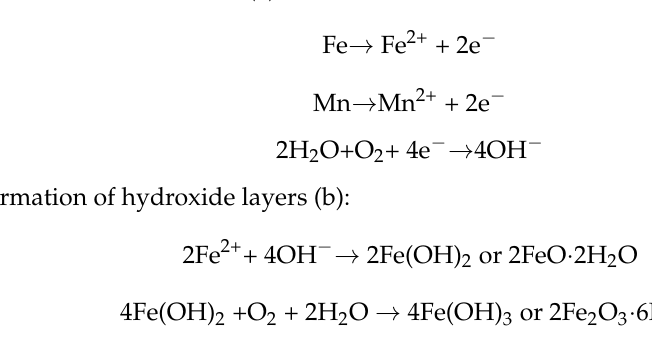
Figure 4. The pH variation during 72 h of immersion at 37 ◦ C of melted and wrought sample. Chloride ions compensated for the growth of metal ions under the hydroxide layer by penetrating the metal substrate. The metal chloride formed was then hydrolyzed into hydroxide and free acid; see Equation (6). This decreased the pH value in the pitting pits, and the solution remained neutral. An in vitro static and dynamic degradation was performed [4,5]. The decrease in the solution’s pH was observed after immersion for 16–17 h for both C and W samples, with different rates, approximately 60 to 90 min for melted sample and 500 min, with pH variations based on different areas of breakthrough, for wrought sample. It can be observed that the cast sample of FeMnSi presents a faster corrosion rate than the wrought material, due to a bigger grain structure and main structural defects obtained from melting.